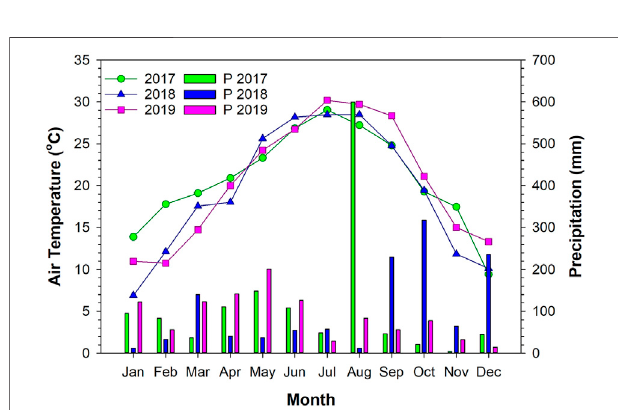
FIGURE 4 | Monthly average air temperature and cumulative precipitation across the 3 years (2017 – 2019) near College Station, TX, United States. The high precipitation in August 2017 was due to Hurricane Harvey.